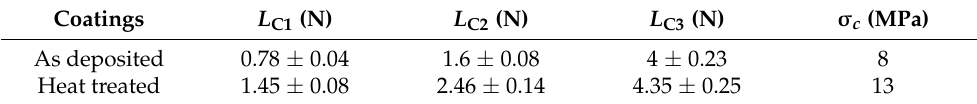
Table 1. Critical loads and adhesion strength of the as-deposited and heat-treated HAP coatings.